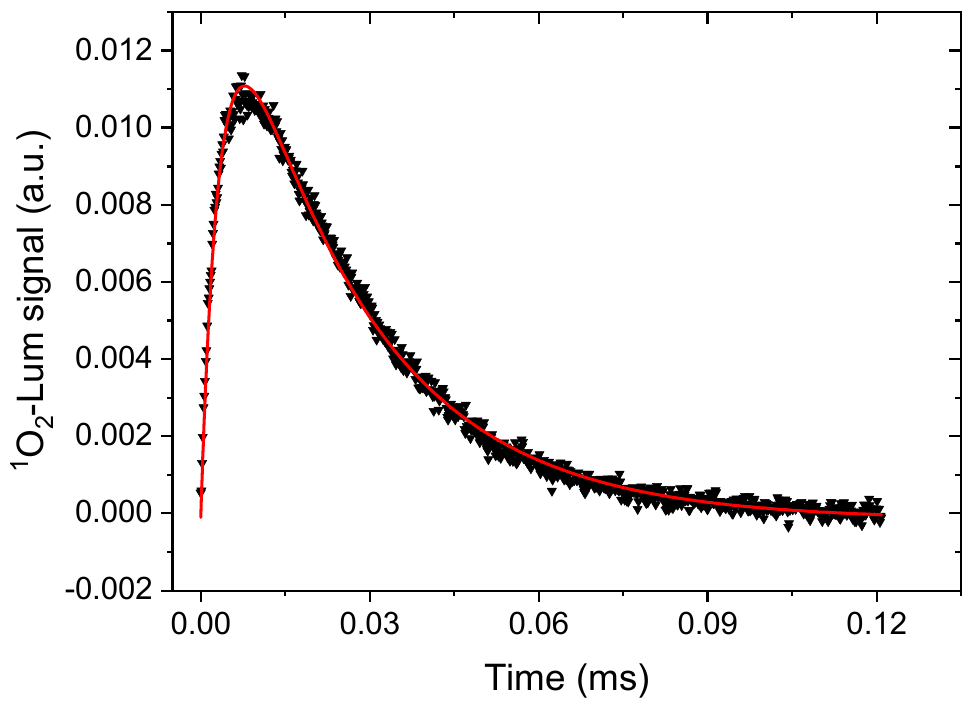
Figure 6. Transient singlet oxygen luminescence at 1275 nm upon excitation of compound 5d at 425 nm in THF. The solid red curve is fit to a double exponential, as described in the text.